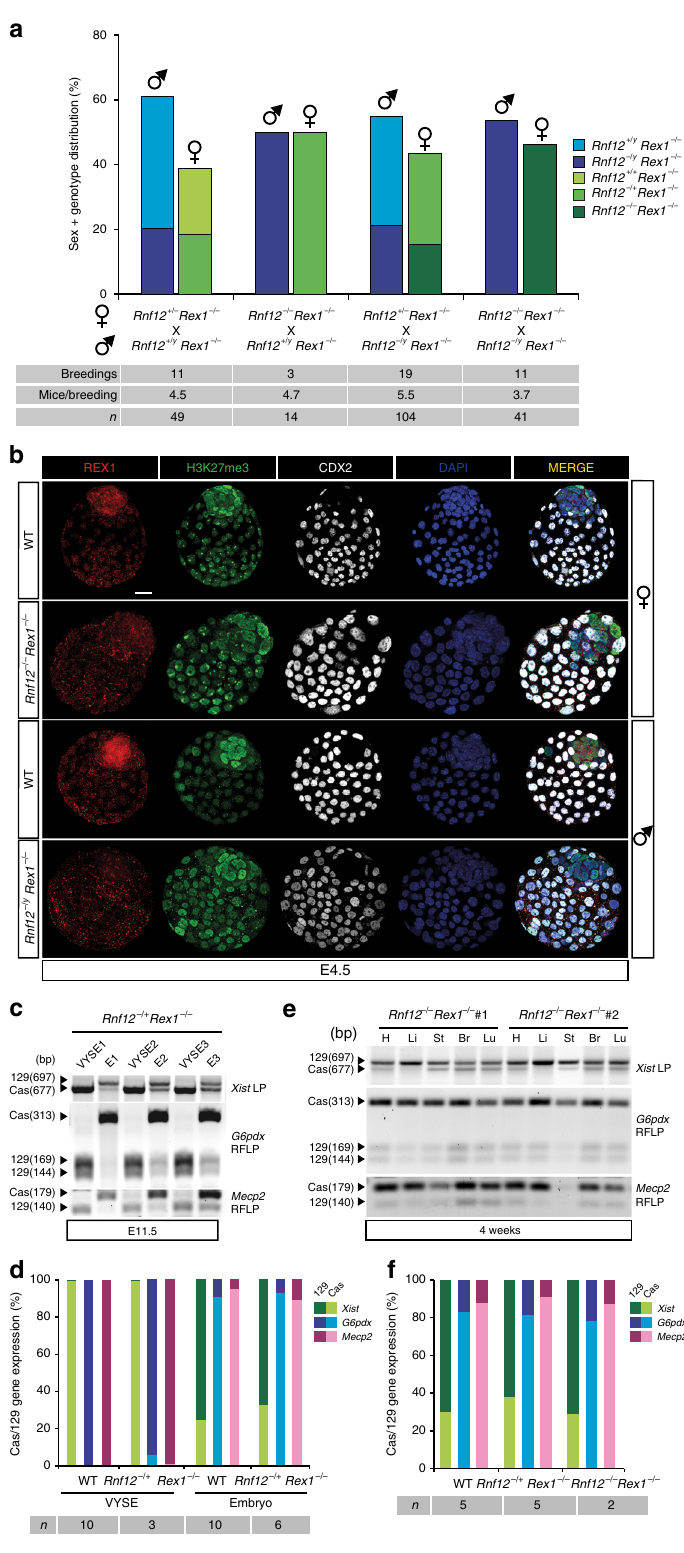
Xm and Xp chromosomes do not display any iXCI defect indi- cating that additional mechanisms are in place to facilitate maintenance of iXCI during embryonic development in the absence of REX1. During rXCI, the Xist 5 ′ regulatory region containing YY1 binding sites becomes asymmetrically